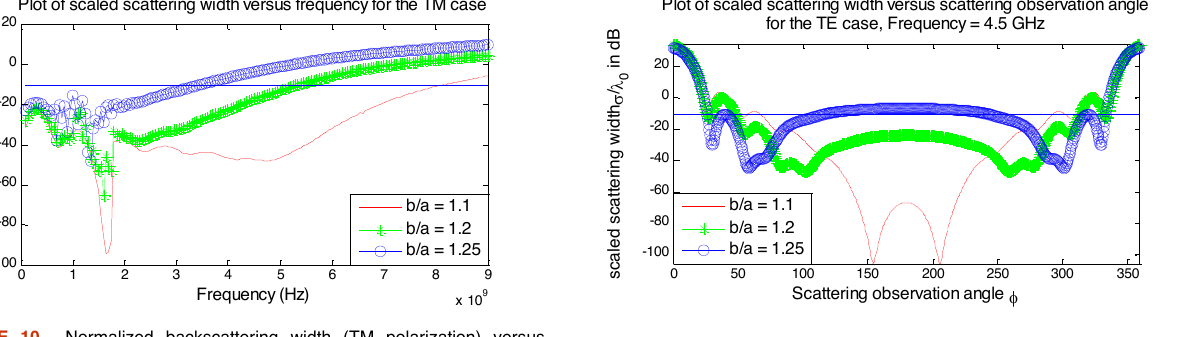
FIGURE 12. Total Scattering Cross Section for TE incidence at f 0 = 4.5 GHz with rings and rods media coating.